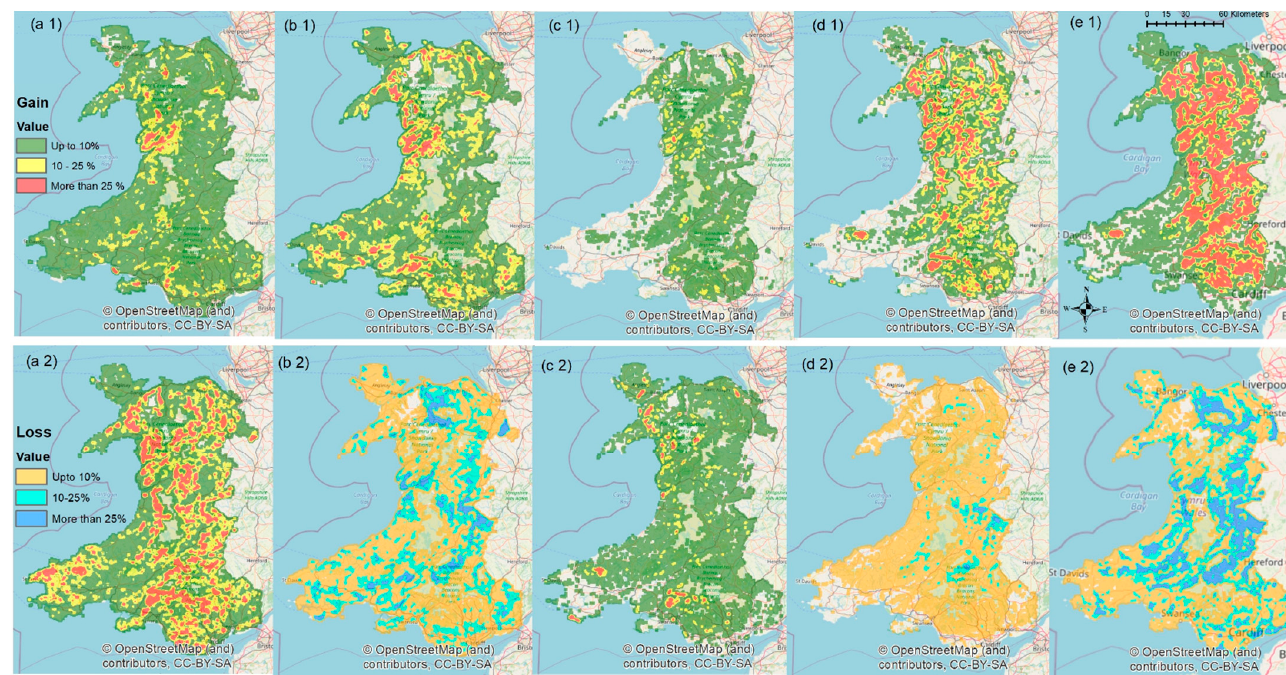
Figure 2. LULC maps of Wales projected to 2030 under a range of scenarios representing possible post-Brexit futures. Maps indicate the effect of Business as Usual (B-a-U, ( a ), Green Future (GF, ( b ), Free Trade Agreement (FTA, ( c ), World Trade Organisation (WTO, ( d ) and Unilateral Trade Liberalisation (UTL, ( e ) scenarios.